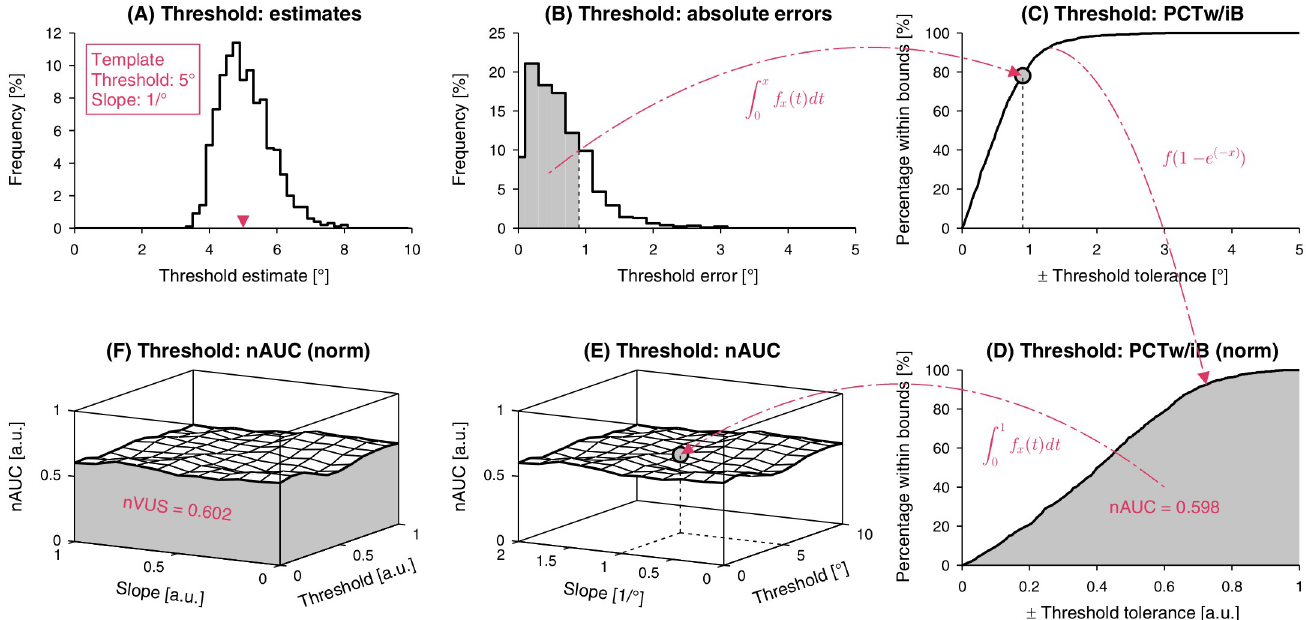
Fig 3. Explanation of performance metrics to characterize psychophysical sampling procedures. (A) Distribution of threshold estimates for a given template. (B) Distribution of the absolute errors. (C) Percentage within bounds ( PCTw/iB ) as a function of the tolerance interval. Each point of this function is generated by integrating the area of the absolute error distribution from zero to the respective error, respectively tolerance, value. (D) After a nonlinear transform of the x axis to [0, 1], the normalized area under the curve ( nAUC ) can be calculated (1 corresponding to perfect estimation for this template). (E) When the nAUC is computed for different templates within a threshold and slope parameter space, the performance can be visualized as a surface in a three-dimensional space. (F) After normalizing the parameter space axes to [0, 1], the normalized volume under the surface ( nVUS ) can be calculated (1 corresponding to perfect estimation across all templates). Note that the metrics are illustrated for the present application of proprioceptive joint angle assessments using a 2AFC paradigm, for a psychometric function template c > 5 � ; 1 = �